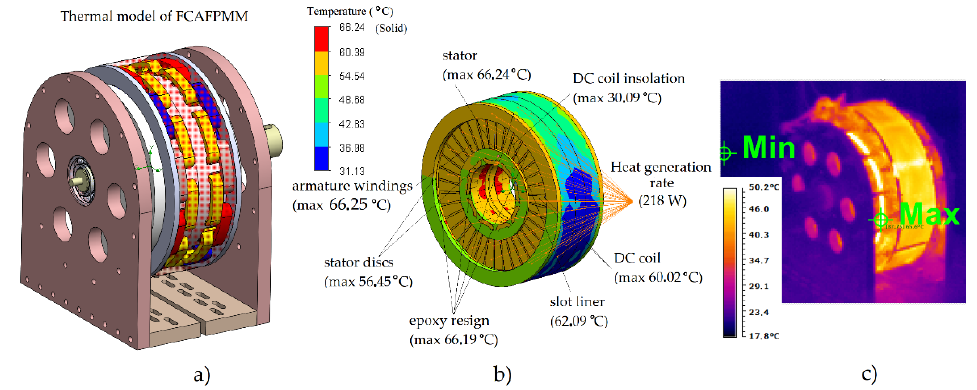
Figure 12. Three-dimensional thermal model of FCAFPMM ( a ); 3D FEA results of thermal distribution on the stator ( b ); thermal imaging result ( c ).